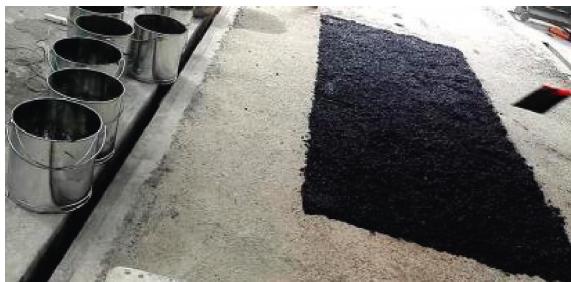
Figure 6: Paving the hard sandstone asphalt mixture.